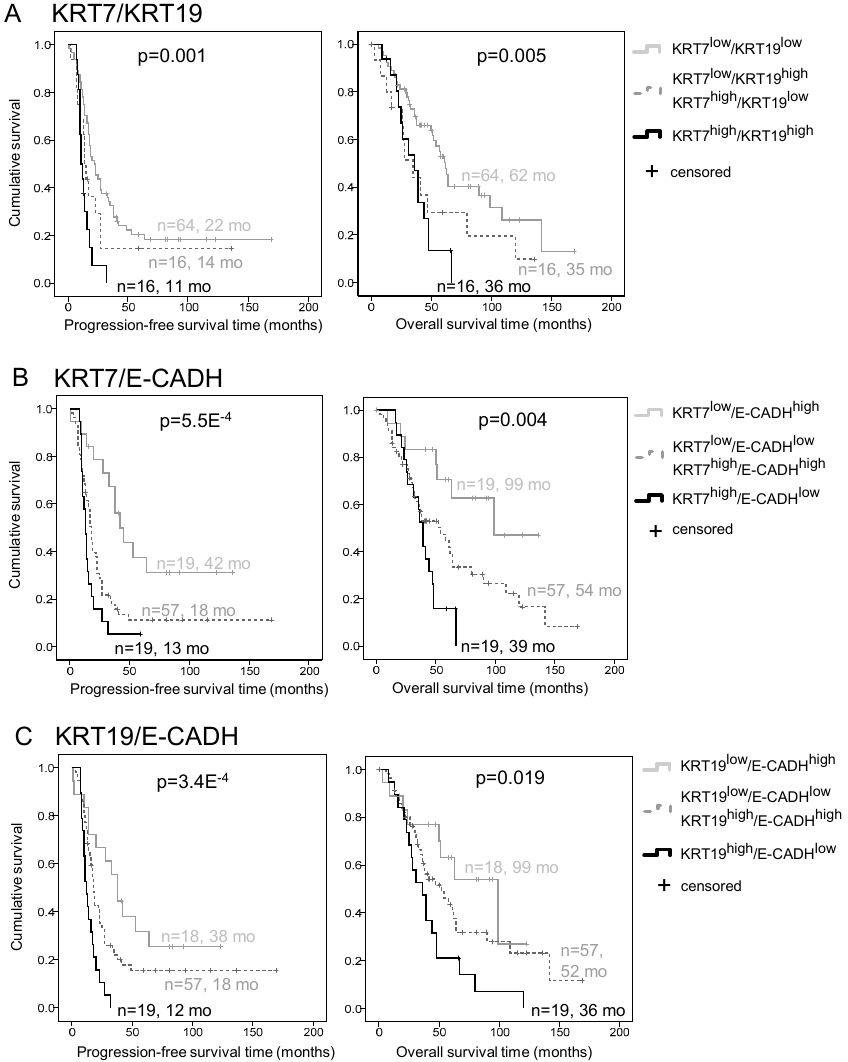
Figure 3. Combination of KRT7 and E-CADH expression improves the prediction of HGSC prognosis in the Discovery cohort ( n -101). (A–C) Kaplan–Meier curves of KRT7/KRT19 ( A ), E-CADH-KRT7 ( B ), and KRT19/E-CADH ( C ) signature associations with progression-free survival (left) and overall survival (right). Expression of markers (MFI) was dichotomized by the 75th percentile into groups of low and high expression, and groups of patients were categorized as indicated in the legends. p values are indicated. Number of patients and estimated median survival months (mo) are indicated for each group.